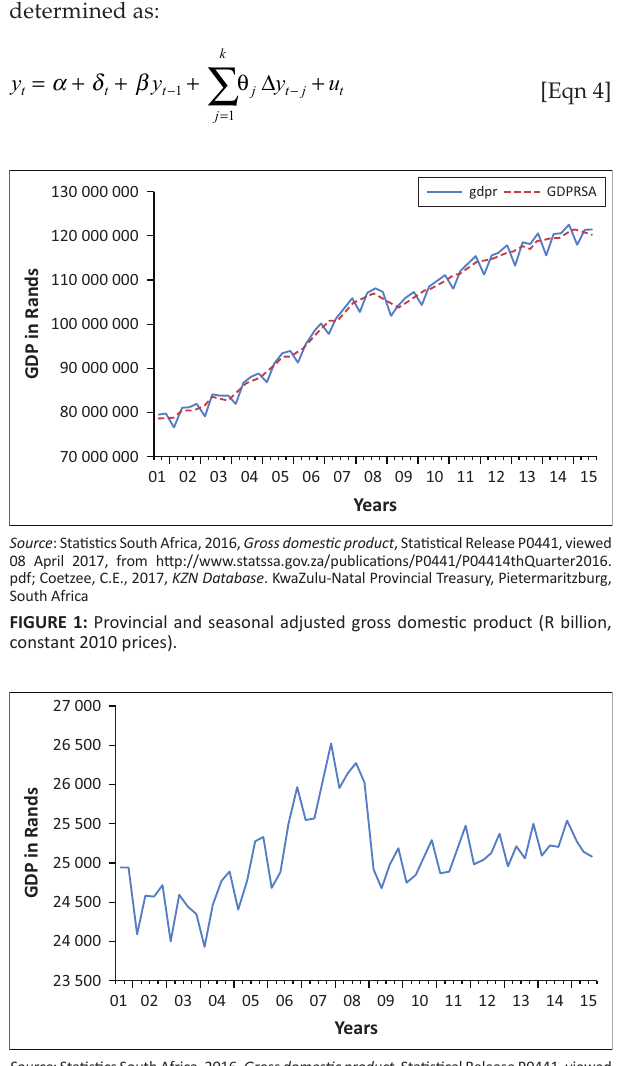
FIGURE 3: Log of first difference of the provincial seasonal adjusted gross domestic product per skill adjusted labour supply (2010